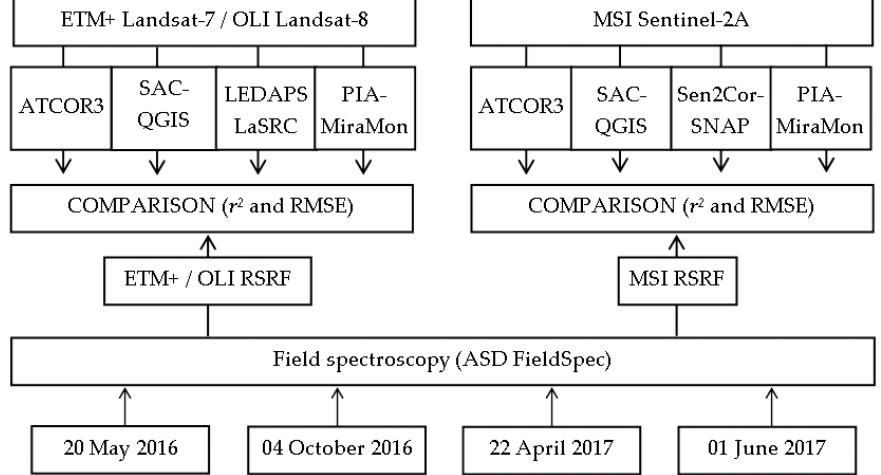
Figure 7. General workflow, for a given date, of radiometric correction methods and their comparison with field spectroradiometry data.